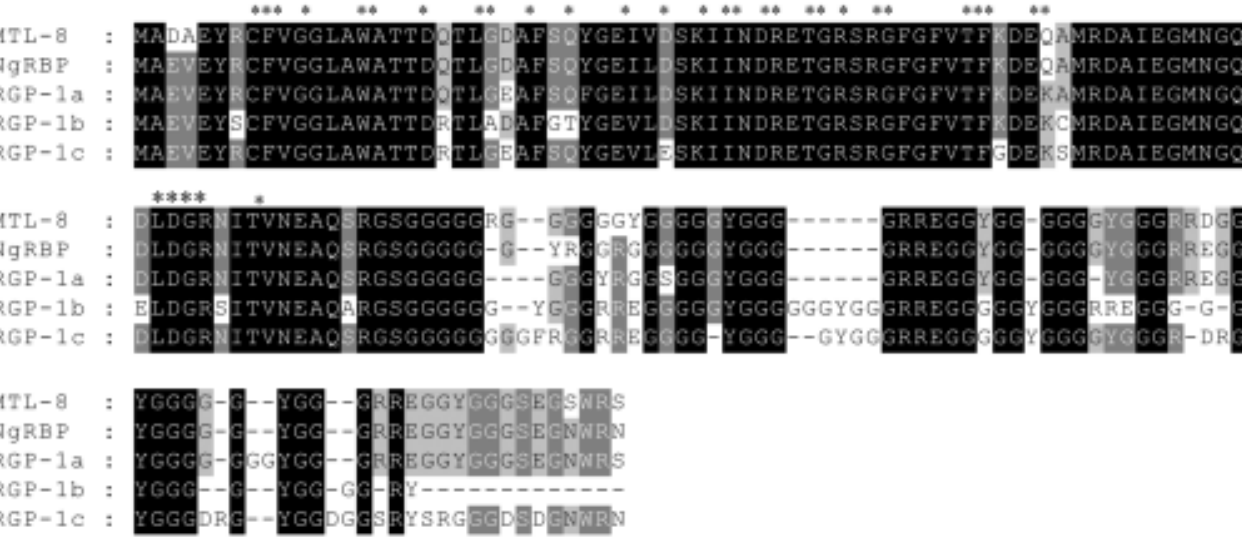
Figure 2. Alignment of the amino acid sequences corresponding to the MTL-8 RT-PCR fragment, a Nicotiana glutinosa RNA-binding protein (NgRBP) (accession number AF005359) and three glycine-rich RNA-binding proteins from N. sylvestris (RGP-1a, RGP-1b and RGP-1c, accession numbers D16204, D16205 and D16206, respectively). Alignment was obtained with the Clustal W program (http://www.ch.embnet.org/cgi-bin/clustalw_parser). Black boxes indicate conserved amino acids in all proteins, dark gray boxes indicate conserved amino acids in four proteins, and light gray boxes conserved amino acids in three proteins. The amino acids relevant to the RNA recognition motif are marked with